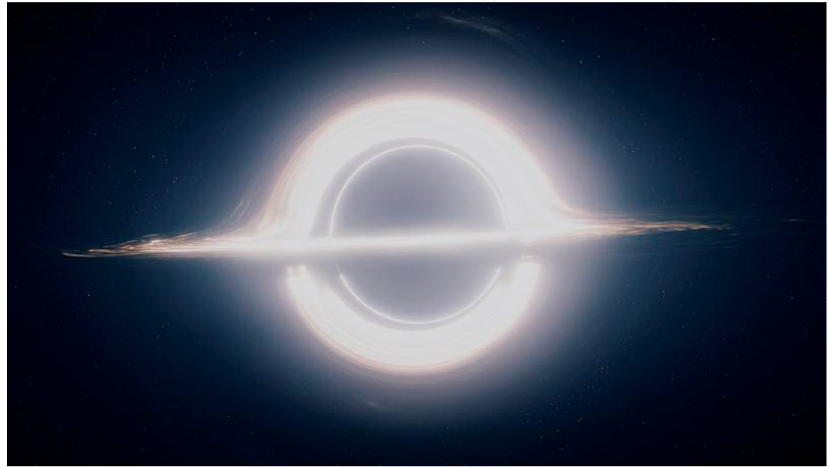
Figure 3. Simulation of an accretion disk around a Kerr black hole as seen by an observer in the equatorial plane, shown in the movie Interstellar . © Double Negative artists/DNGR/ TM & © Warner Bros.